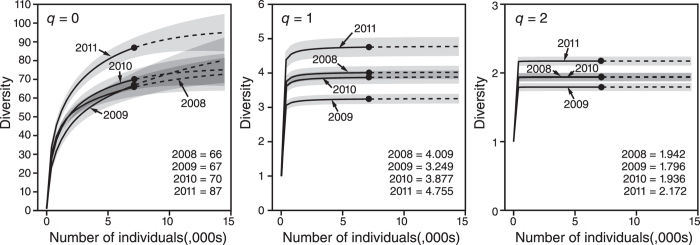
Sample-size-based rarefaction (solid line) and extrapolation (dashed lines up to double the reference sample size) of foraminiferal diversity for Hill numbers.q = 0 (left panel), q = 1 (middle panel), and q = 2 (right panel). Reference sample for each sampling interval is indicated by a solid dot and the calculated Hill numbers are listed in the bottom right corner. Across the four sampling intervals, total foraminifera species richness (q = 0) equals 109 taxa. The result of extrapolation of total species richness for double the reference sample size is 122 taxa and has not yet reached the asymptote.